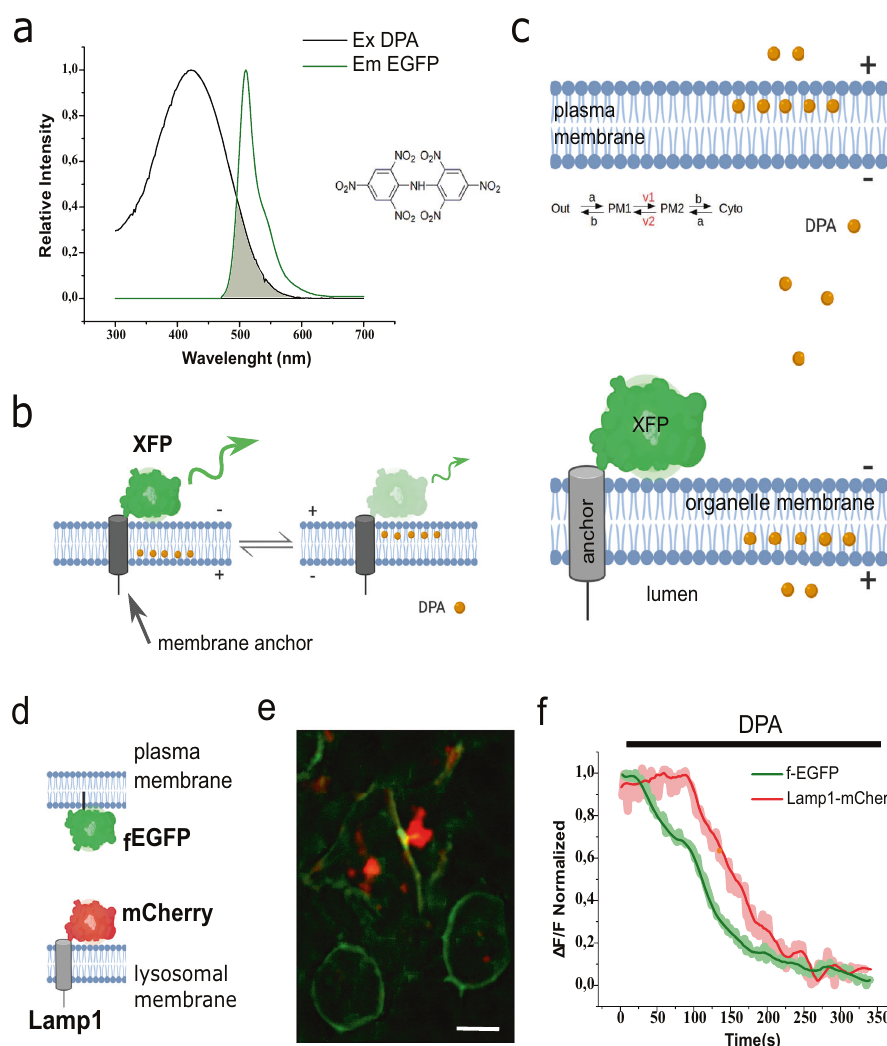
Fig. 1 Dipicrylamine (DPA) reaches internal membranes. a Overlap between the spectra corresponding to EGFP emission and DPA absorption. A DPA molecule is pictured as inset. b Schematic representation of DPA transit in the HVoS technique. The negatively charged DPA accumulates preferentially at the positive lea fl et of the membrane and redistributes in response to changes in membrane voltage. Redistribution of DPA within the membrane cause distance-dependent quenching of EGFP emission. c Schematic representation of DPA incorporation and distribution within the cell. Equilibrium describes the transit of DPA within a single membrane. Once at the membrane, DPA distributes according to a voltage-dependent equilibrium with voltage- dependent rates v1 and v2. d Cartoon depicting the topology of the probes used for simultaneous measurements of plasma membrane and lysosomes. e Simultaneous expression of Lamp1-mCherry (lysosomal marker) and farnesylated GFP ( f EGFP; plasma membrane marker) in HEK293 cells. Bar = 10 μ m) f Time course of fl uorescence for the cell in panel e during DPA incorporation. The lysosomal signal (red trace) corresponds to the average of six spots proximal to the membrane and centered in the cell. The plasma membrane signal (green trace) was extracted from four regions of equal